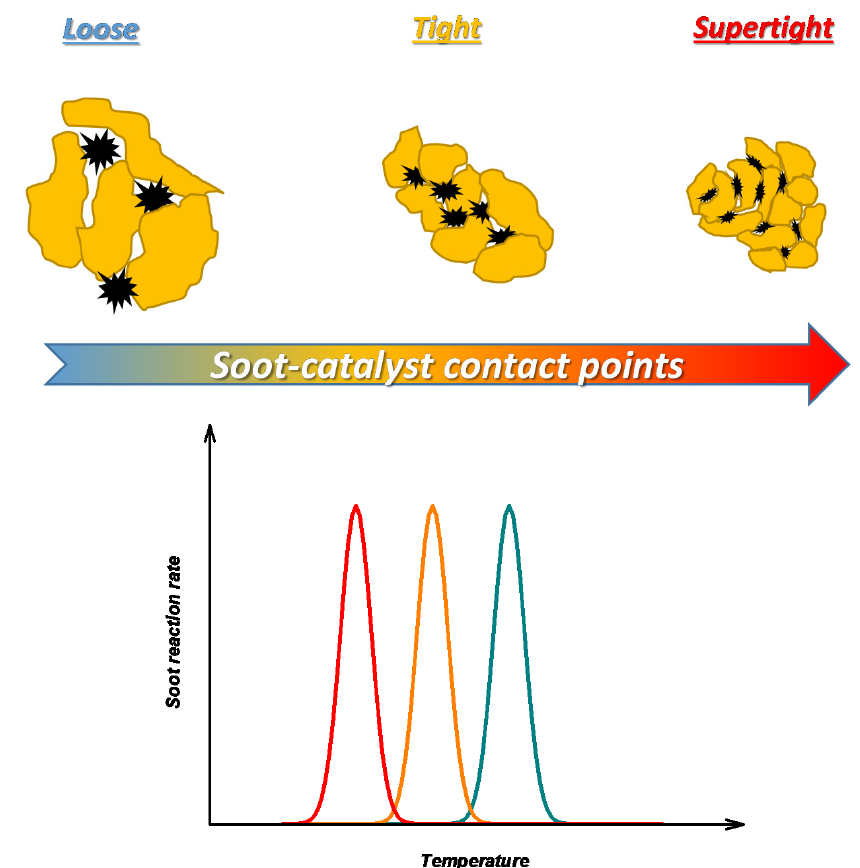
Figure 1. Qualitative trend of soot oxidation temperature with soot-catalyst contact intensity (i.e., number of soot-catalyst contact points): temperature decreases when going from loose to tight and supertight contact conditions.